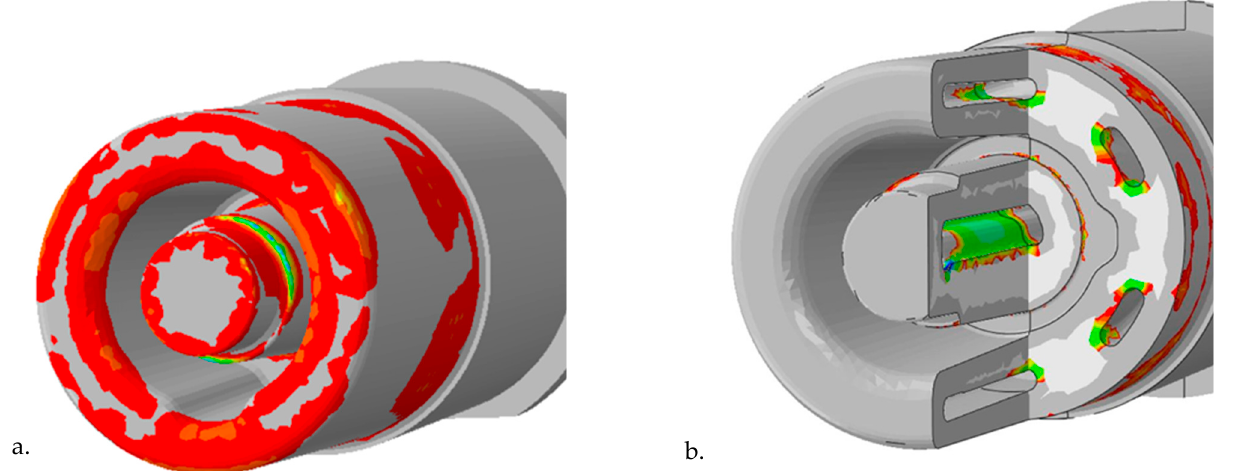
Figure 13. Colour-coded numerically defined zones with the lowest fatigue life: ( a ) outer surfaces of the core (110,000 to 150,000 cycles); ( b ) the cooling channel surfaces (80,000 to 120,000 cycles).